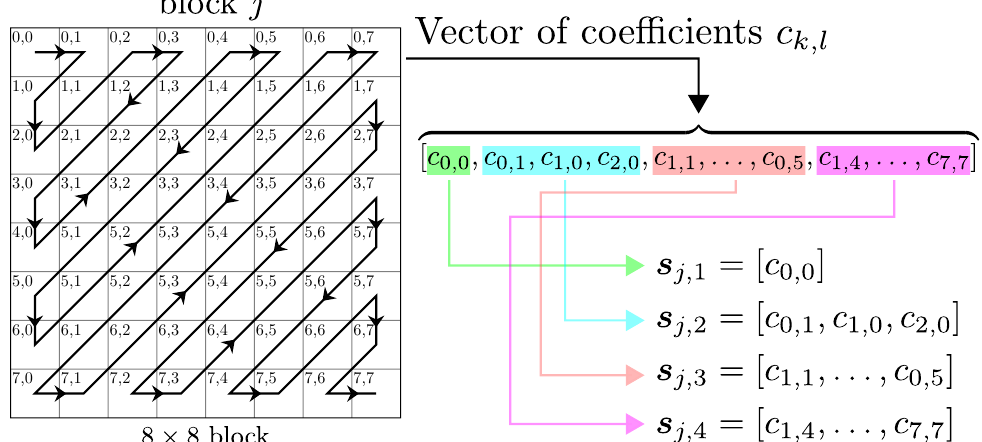
Figure 3. Graphical representation of the division applied to the j -th block of 8 × 8 discrete cosine transform (DCT) coefficients considering n b = 4 sub-blocks, and the way of building the corresponding vectors of coefficients with different levels of detail for the